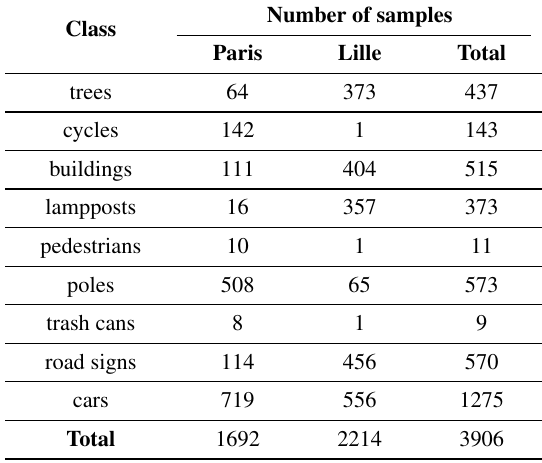
Table 1: Number of samples for each class